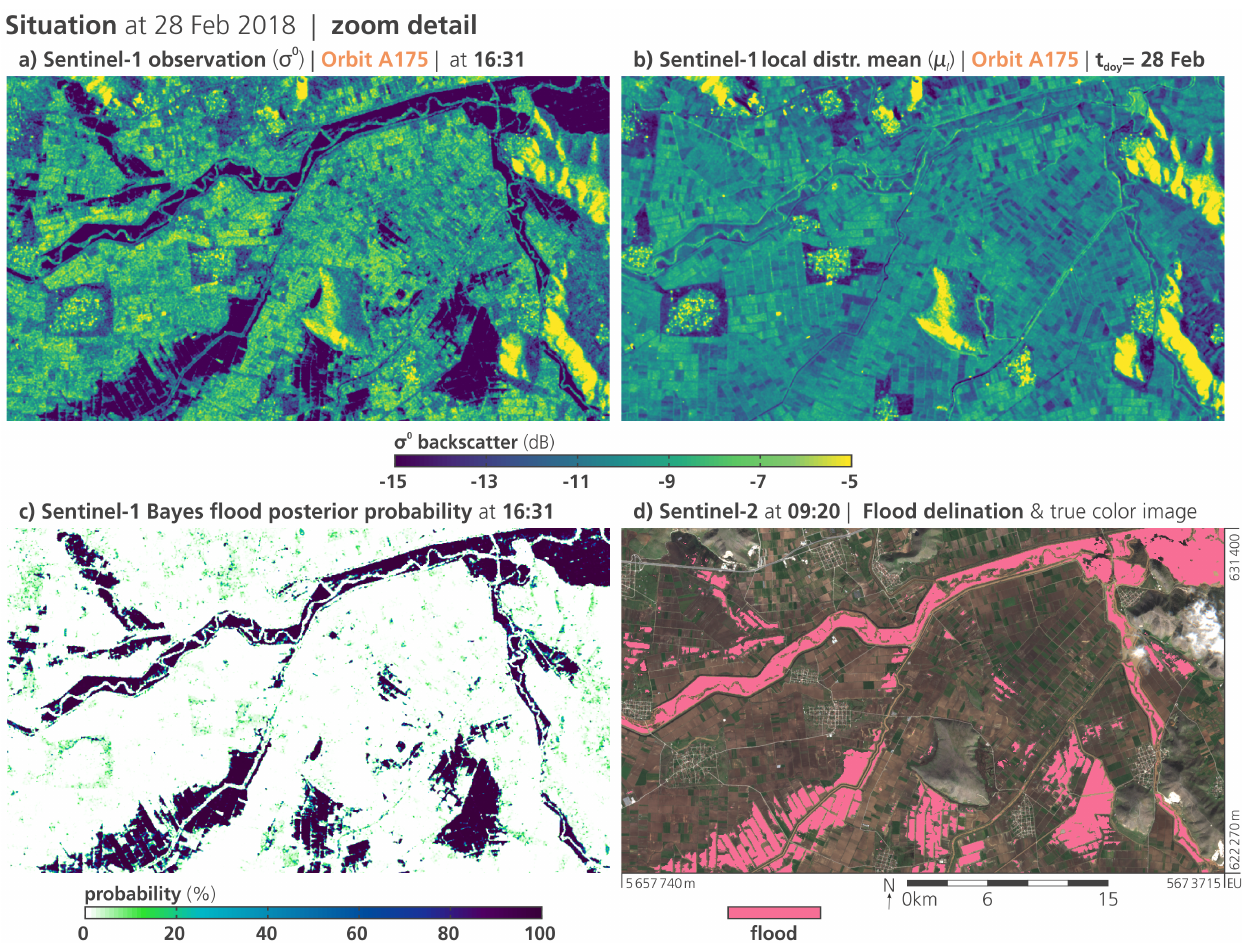
Figure 6. Detailed analysis of Thessaly flood situation on 28 February 2018, comparing ( a ) the backscatter image observed by Sentinel-1 from ascending orbit 175, ( b ) the expected backscatter σ 0 ρ ( t doy ) for 28 February, ( c ) the resulting Bayes flood posterior probability P ( F | σ 0 ) , and ( d ) the flood map from Sentinel-2 NDWI on the preceding morning with the corresponding RGB image in the